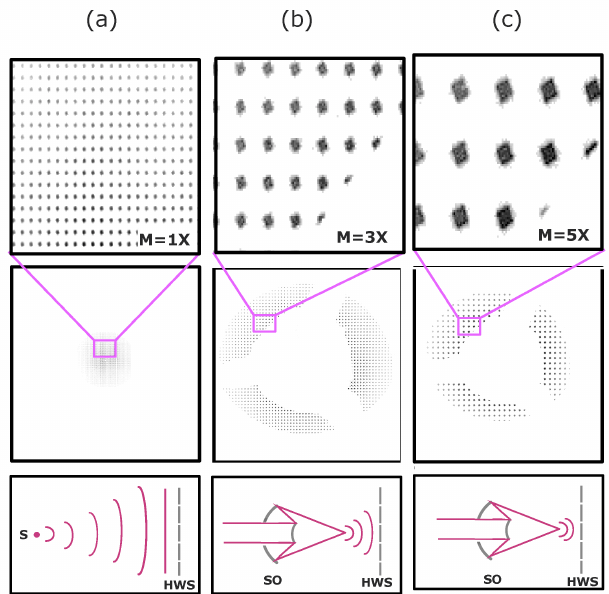
Figure 2. Hartmann pattern overview of direct beam compared with pattern on the HNA-HWS after it propagated through the Schwarzschild at different distances. ( a ) Beam propagated directly from the source (S) and did not magnify the Hartmann plate. ( b ) Pattern through Schwarzschild objective (SO) when it was focused 25 mm apart from the grid, introducing M = 3 ˆ magnification due to wavefront curvature. Annular pattern was divided in three sections as a consequence of the three fins of the mount that supported the concave mirror. For an SO focusing closer, i.e., 17 mm from the grid ( c ), the wavefront curvature was stronger, the magnification effect rose to M = 5 ˆ , and total pattern dimensions were